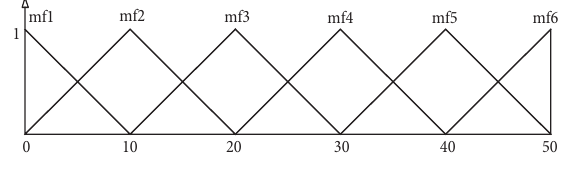
Table 3. Weights among different types of